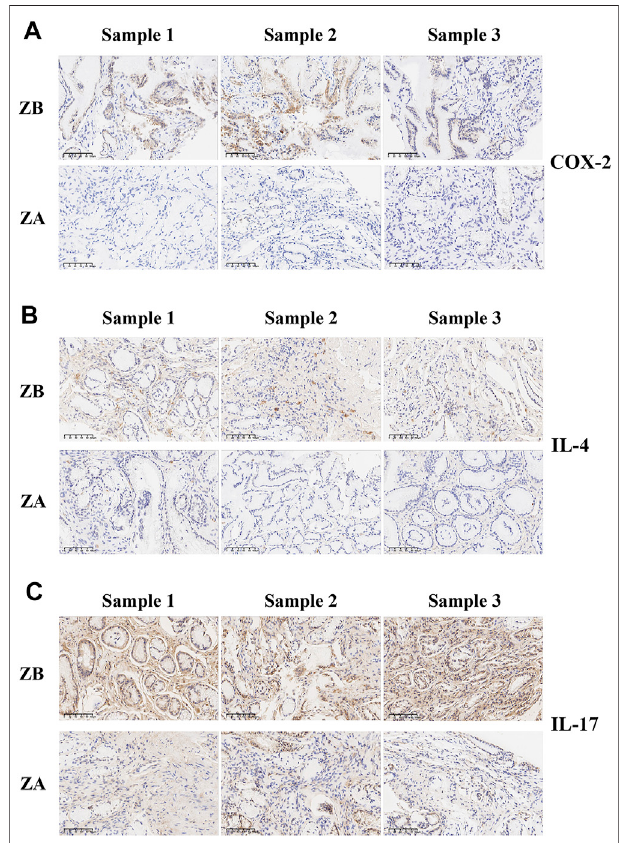
FIGURE 6 | Immunohistochemical staining of in fl ammatory factors before or after ZJP treatment in gastric mucosa. ( (A) Expression of COX-2 in patients ’ gastric mucosa; (B) expression of IL-4 in patients ’ gastric mucosa; (C) expression of IL-17 in patients ’ gastric mucosa; ZA, ZJP after treatment; ZB, ZJP before treatment).